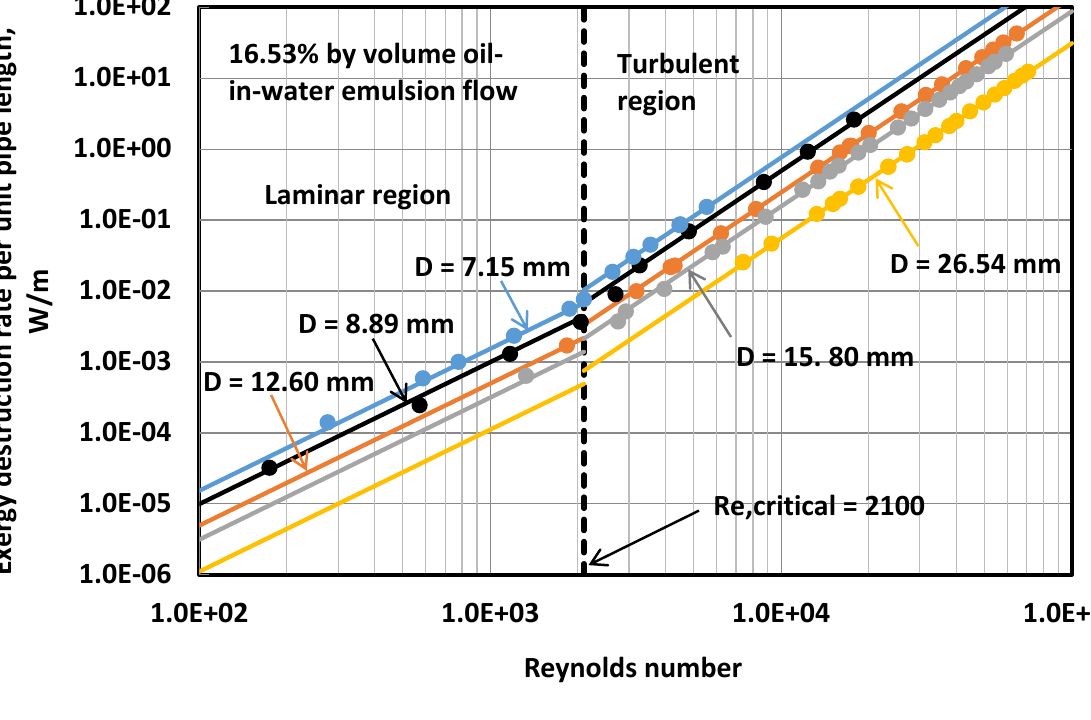
  versus Re plots for 30.4% by vol. O/W emulsion flow in different diameter pipes.